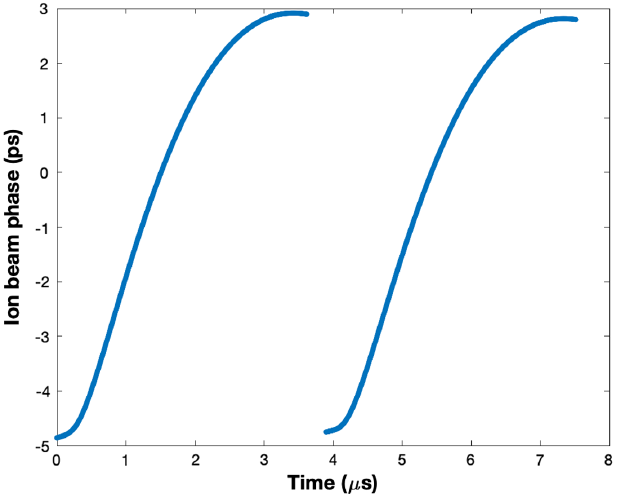
FIG. 3. Ion beam synchronous phase